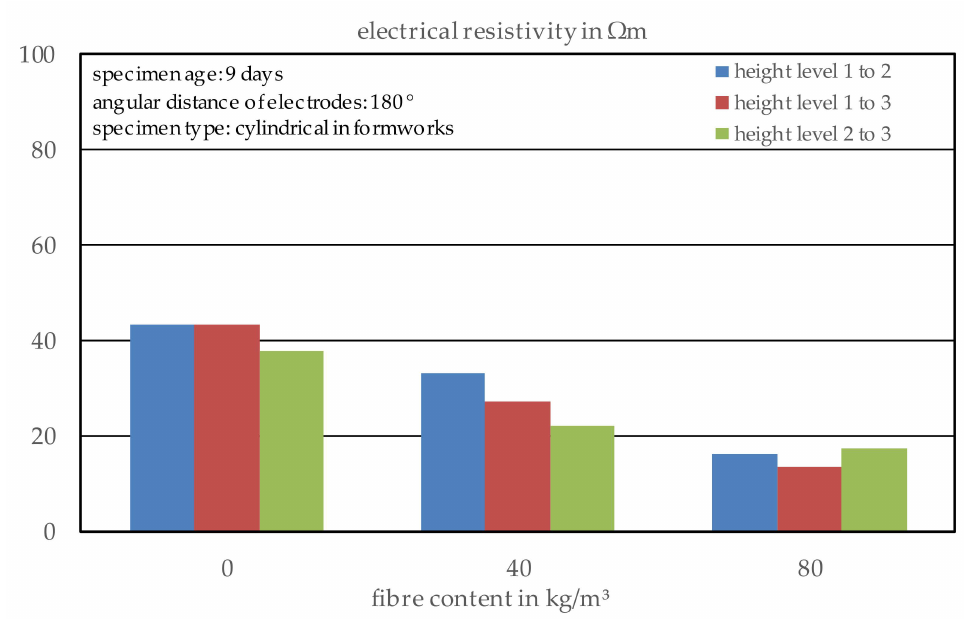
Figure 9. Electrical resistivity in the vertical direction with different combinations of electrodes depending on fibre content at a specimen age of 9 days and an electrode array with angular distances of 180 ◦ .